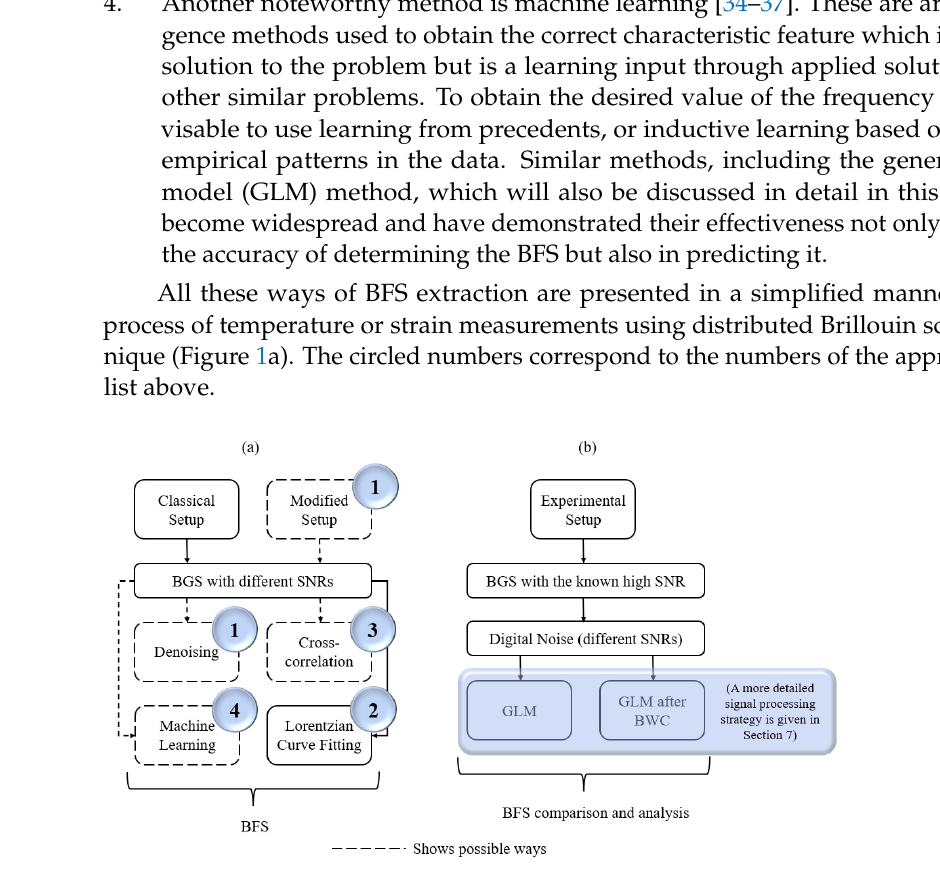
Figure 1. The classical approach of the BFS extraction process ( a ) in comparison with the proposed study ( b